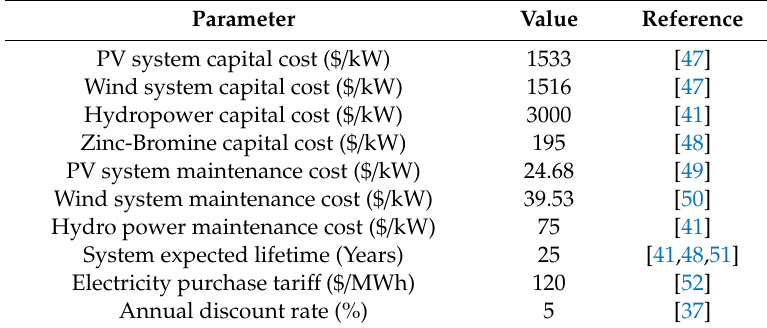
Table 2. The economic parameters of the PV, the wind, and the hydropower systems in addition to the electricity purchase tari ff and the annual discount rate for Al-Tafilah, Jordan.